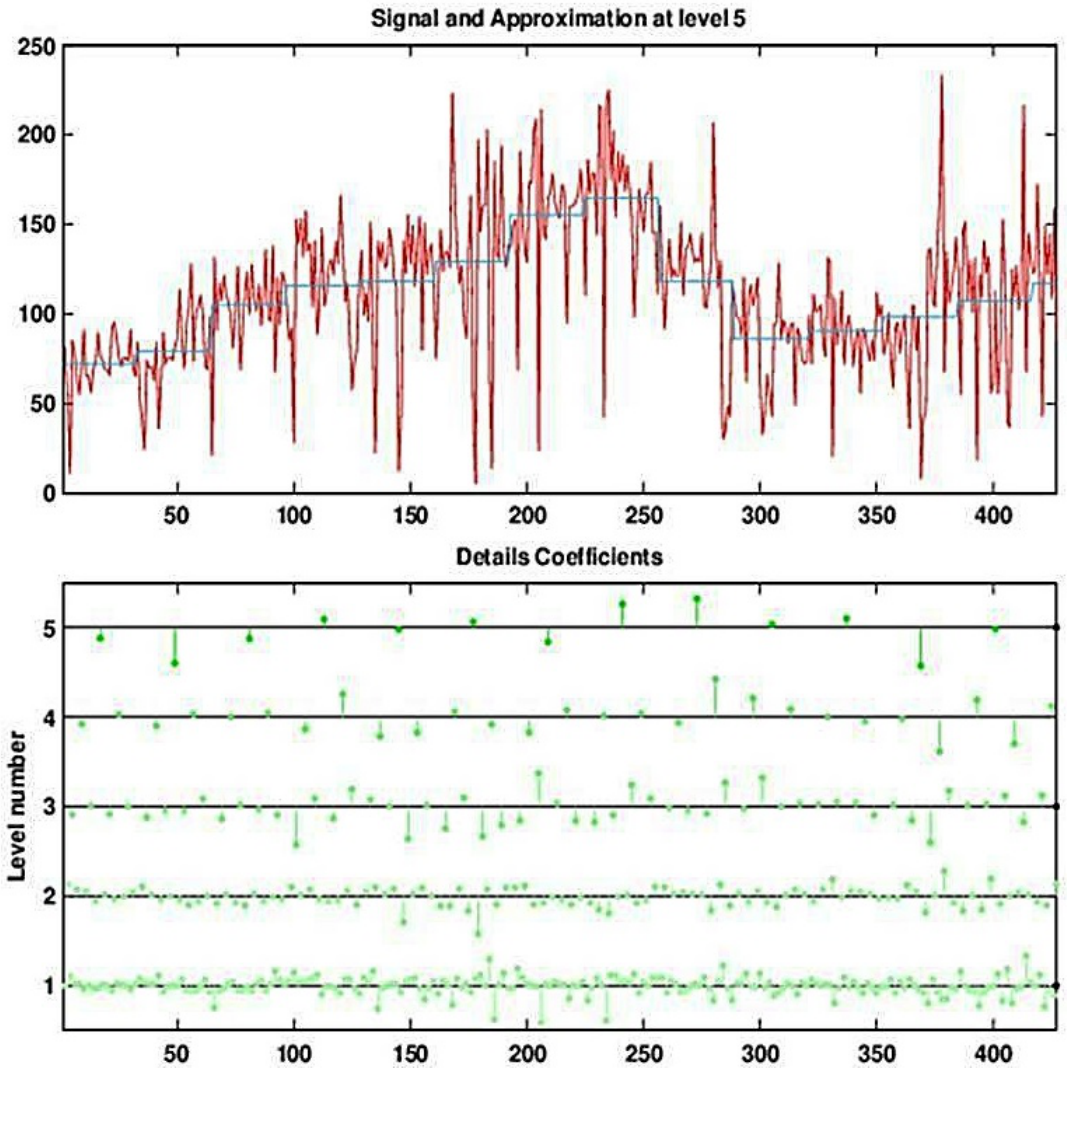
Figure 5. Decomposing the (deseasonalized) series of daily visits to military outpatient clinics into five levels using the Haar wavelet. The top panel displays the time-series overlaid with the fifth approximation (the blocky curve). The bottom panel shows the five levels of detail